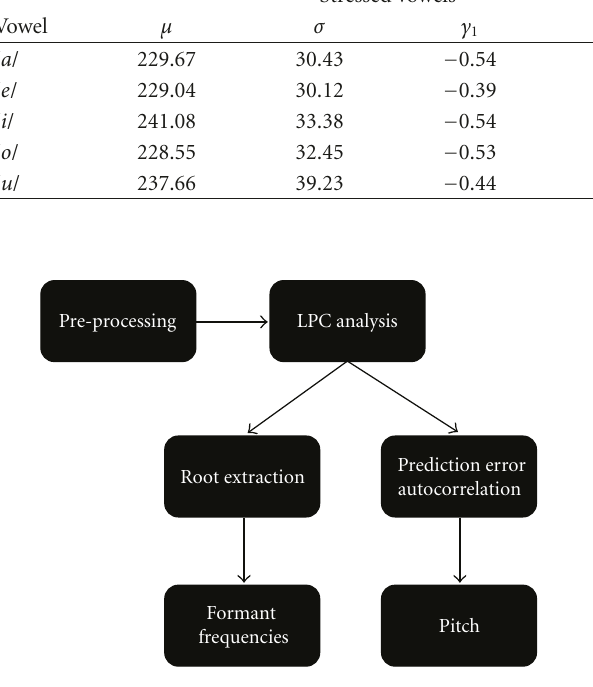
Figure 1: Acoustic analysis